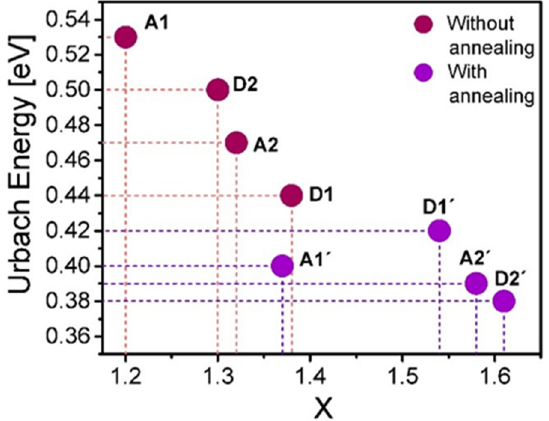
Figure 11. Correlation between the stoichiometric ratio x and the calculated Urbach energy values.